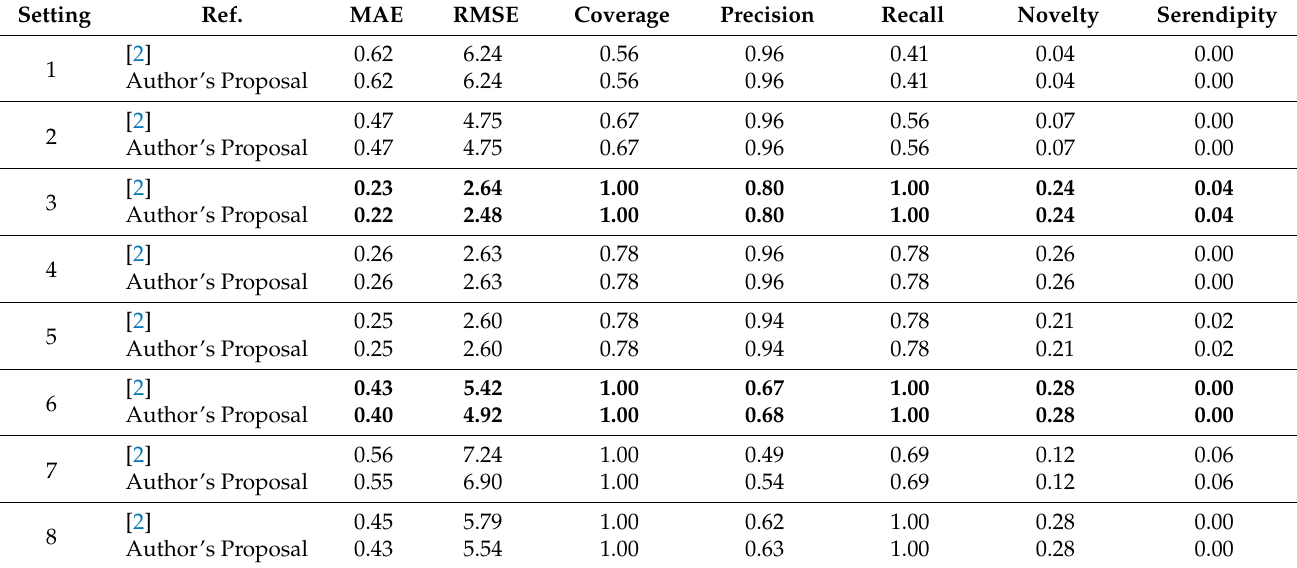
Table 8. Metrics for the different configurations for the set of test data.